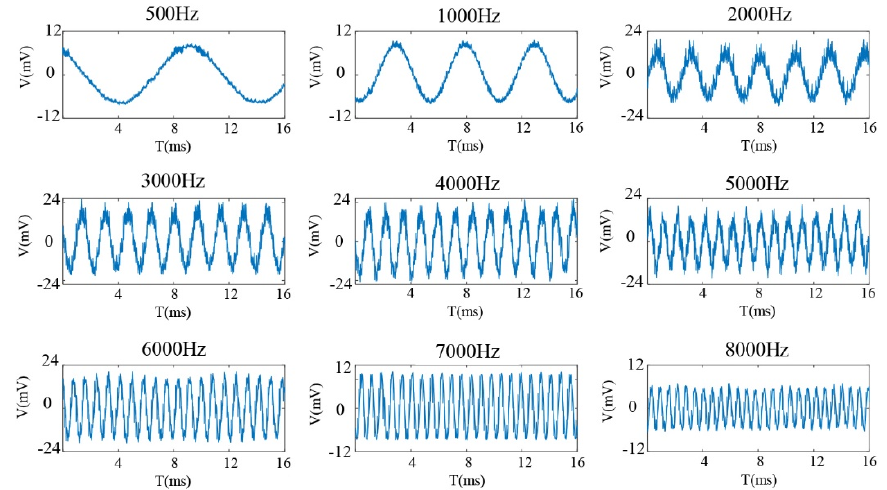
Figure 8 . The responding curve of the sensing system to acoustical signals of 500 − 8000 Hz.